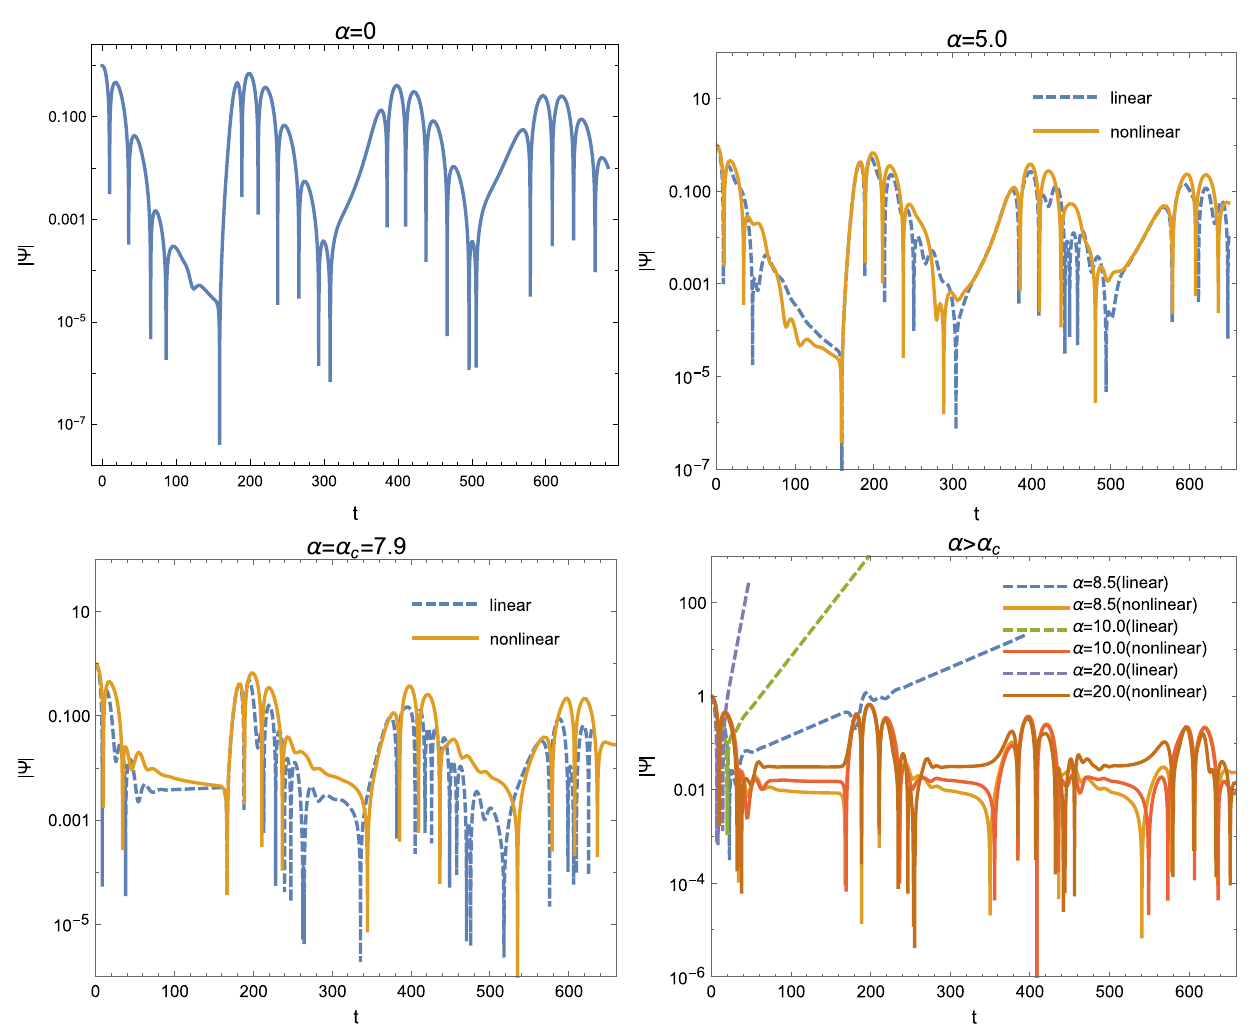
Fig. 2 Time evolutions of the scalar field perturbation for B = 0 . 1 , Q = 0 . 5 and various values of α both in the linear and nonlinear levels (with the nonlinear parameter β = 10 . 0). From left to right and